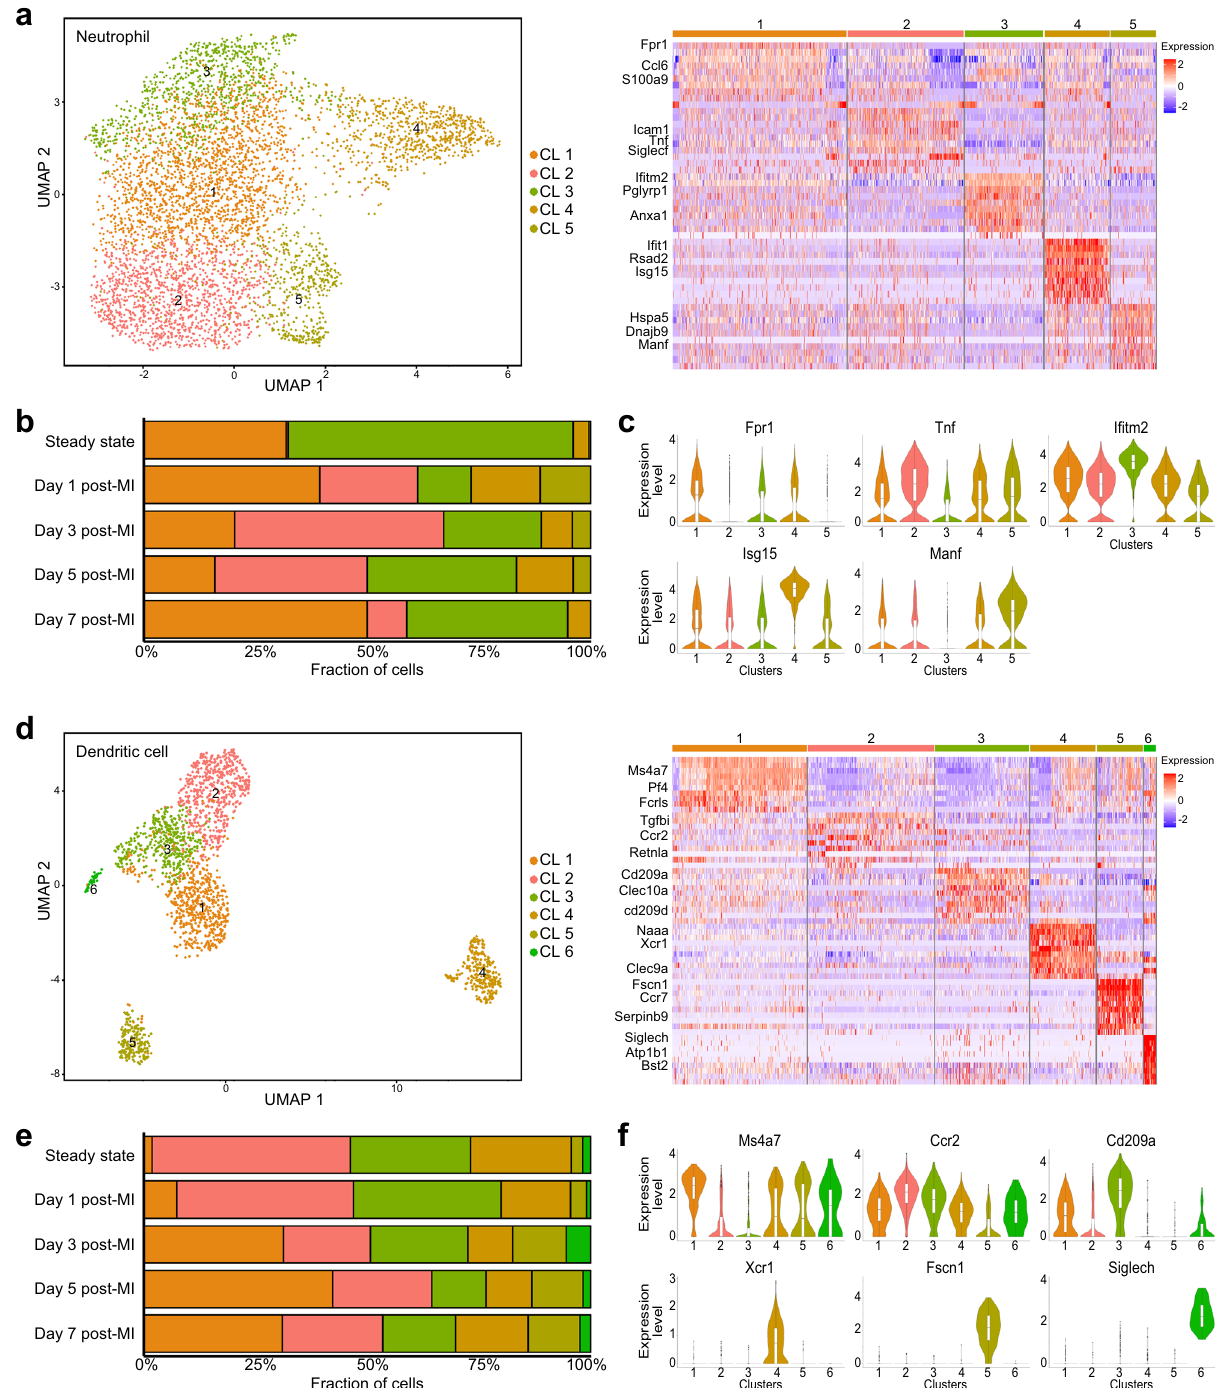
Fig. 4 | Neutrophil and dendritic cell subsets. a The UMAP visualization of 5135 neutrophils identi fi ed fi ve distinct subsets (left panel). Each point represents a single cell, colored according to the sub-cluster assigned. In the right panel, the heatmap shows the top 10most differentially expressed genes in each sub-cluster. Blue and red indicate lower and higher expression, respectively. Typical markers strongly and speci fi cally associated with each sub-cluster are shown on the left. b Bar plot showing the proportions of cells in each of the 5 sub-clusters according tothetime-pointafterMI. c Violinplotsoftheexpressionof Fpr1 , Tnf1 , I fi tm2 , Isg15 , and Manf in neutrophil sub-clusters (Cluster 1: 1864 cells; Cluster 2: 1243 cells; Cluster 3: 844 cells; Cluster 4: 698 cells; Cluster 5: 486 cells). d The UMAP visuali- zation of 1921 dendritic cells identi fi ed 6 distinct subsets (left panel). Each point represents a single cell, colored according to the sub-cluster assigned. In the right